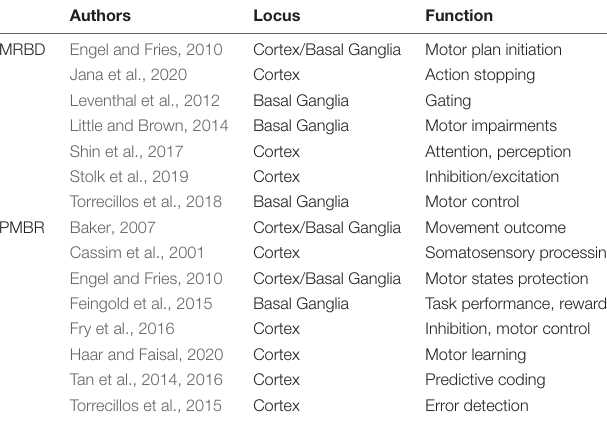
TABLE 1 | Selective list of studies describing beta’s functional role in the sensorimotor